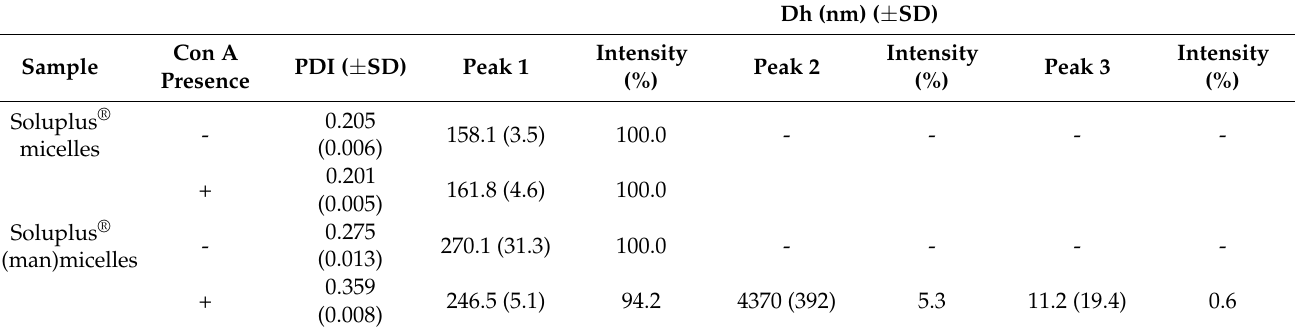
Table 1. Micellar size and size distribution (PDI) of Soluplus ® micelles and Soluplus ® (man)micelles (10% w / v ) in presence and absence of Con A after incubation (2 h) at 25 ◦ C. Data are expressed as mean ± S.D. (n =